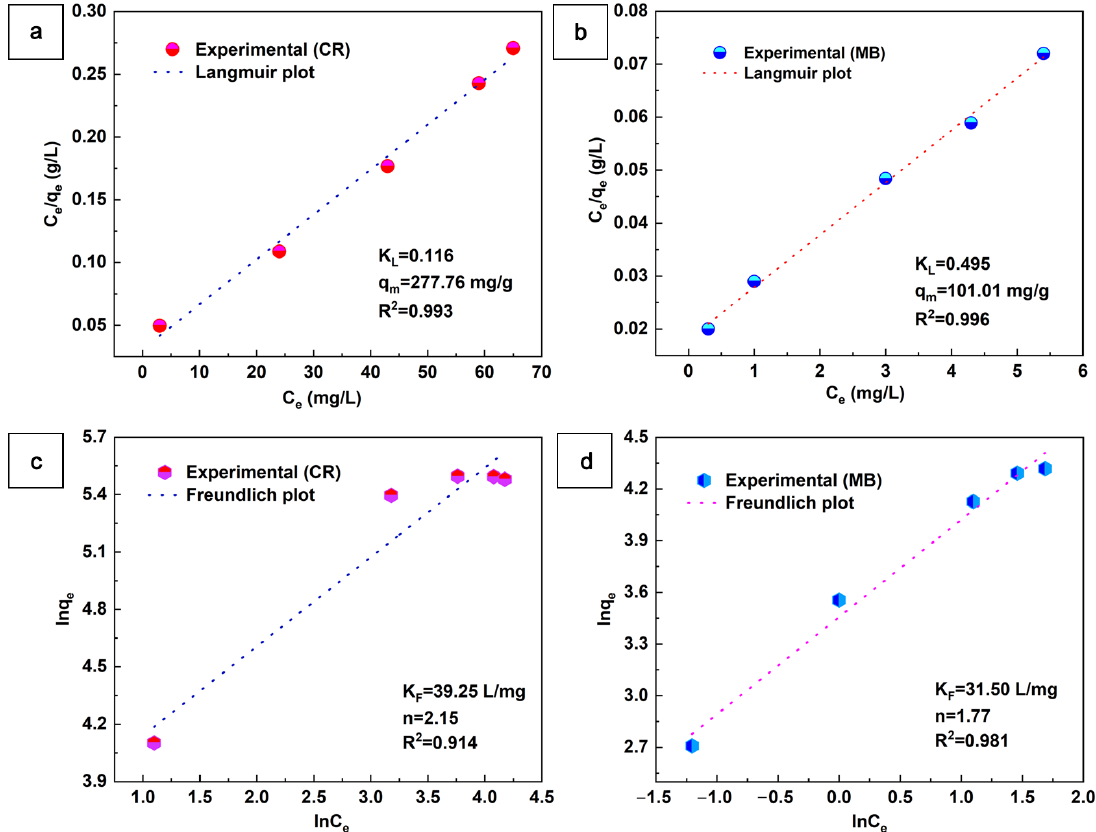
Figure 8. Langmuir and Freundlich isotherms for the adsorption of CR ( a , c ) and MB ( b , d ) on the aerogel (m = 10 mg, V = 50 mL, t = 6 h ).